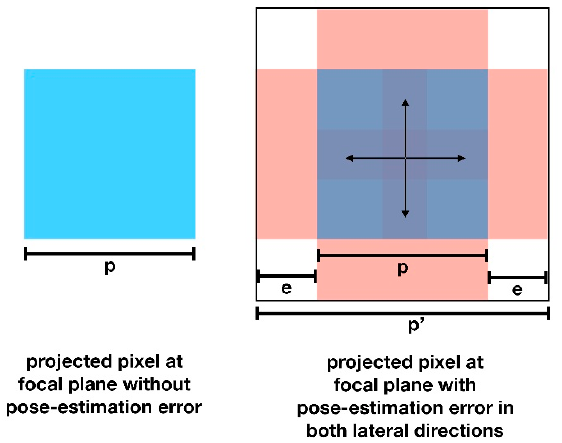
Figure A1. The size p of a pixel projected onto the focal plane at the ground surface increases to p ’ by twice the average pose-estimation error e in both lateral directions. This reduces the effective spatial sampling resolution.